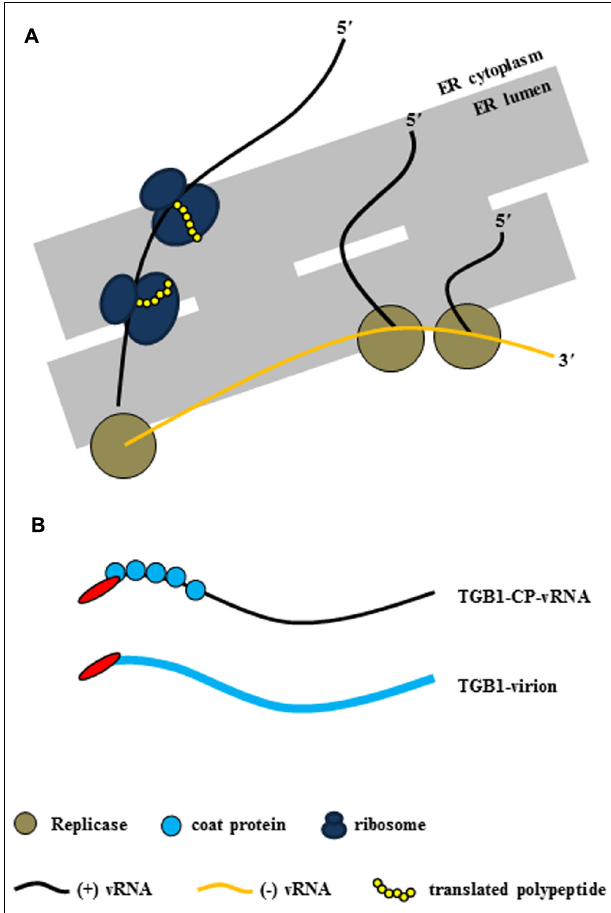
FIGURE 2 |Virus replication complex (VRC) and RNP movement complex in the ER tubule. (A) Potexvirus constructs theVRC, which consists of vRNA, replicase, and host proteins (i.e., ribosomes) for replication of vRNA. Replicase (brown circles) produces progeny ( + ) vRNA from ( − ) vRNA as a template in the ER structure, and host ribosomes (dark blue) translate viral proteins (yellow chain) from progeny ( + ) vRNA. (B) The two kinds of RNP movement complexes in potexviruses. In one case, the PD-transportable form of potexvirus vRNA is partially encapsidated by the CP subunit, andTGB1 protein is associated with the 5 (cid:2) end of the partially CP-coated vRNA (TGB1-CP-vRNA). In the second case,TGB1 protein binds to the CP-encapsidated virion (TGB1-virion).The blue circles indicate CP in the first case, and the thick blue line indicates CP and virion in the second case.